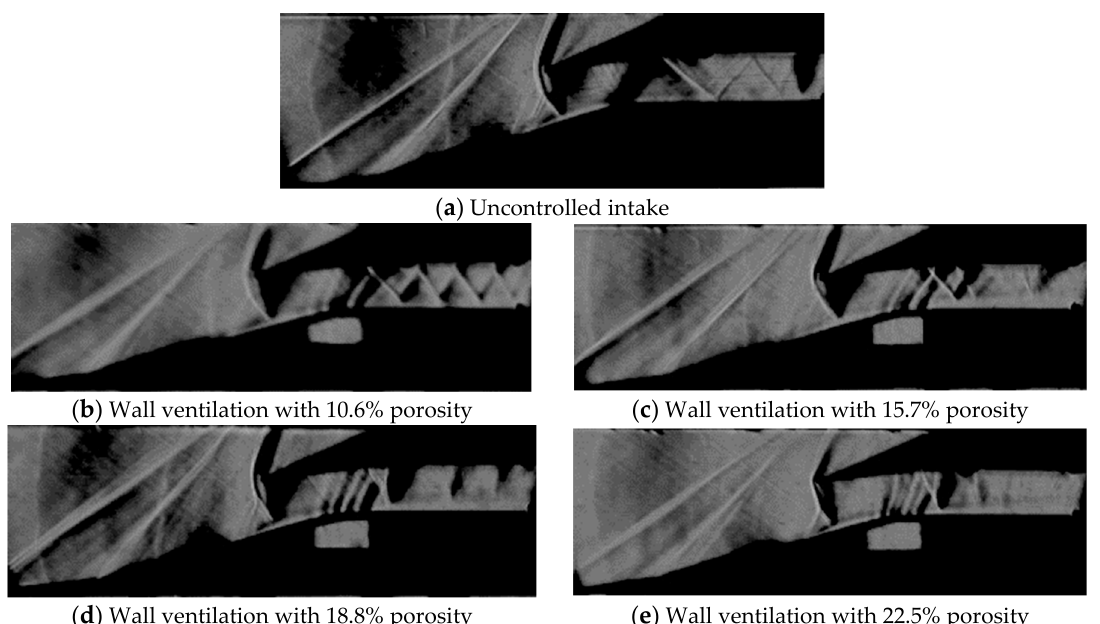
Figure 10. Schlieren view of uncontrolled and wall ventilated intakes at R c = 1.25.